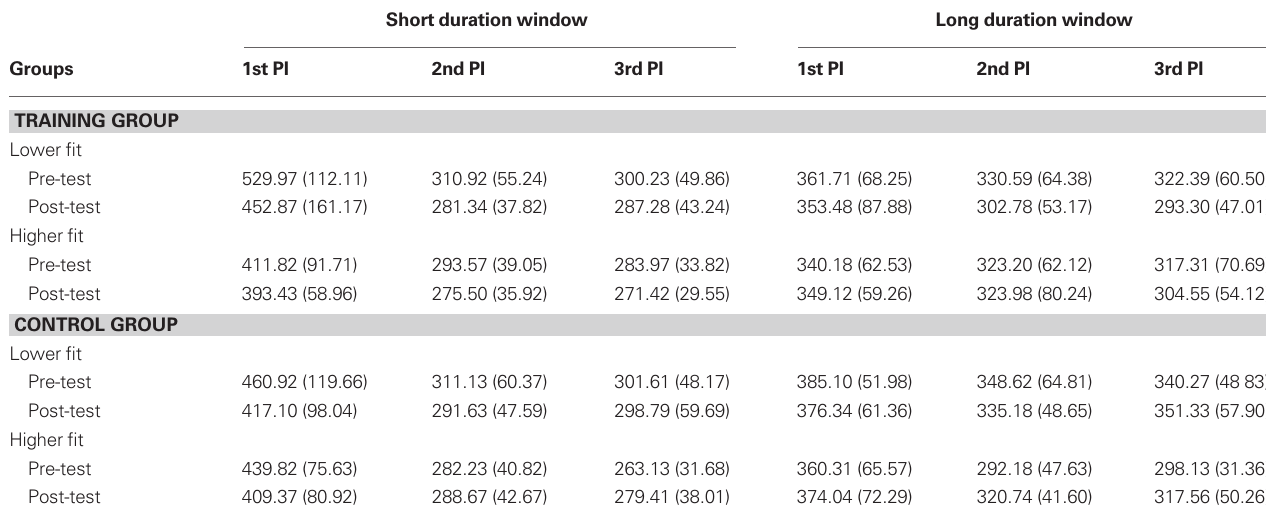
Table 2 | mean initiation time (in ms) and standard deviation (in parentheses) of the simple rT as a function of duration condition and Pi. Short duration window Long duration window